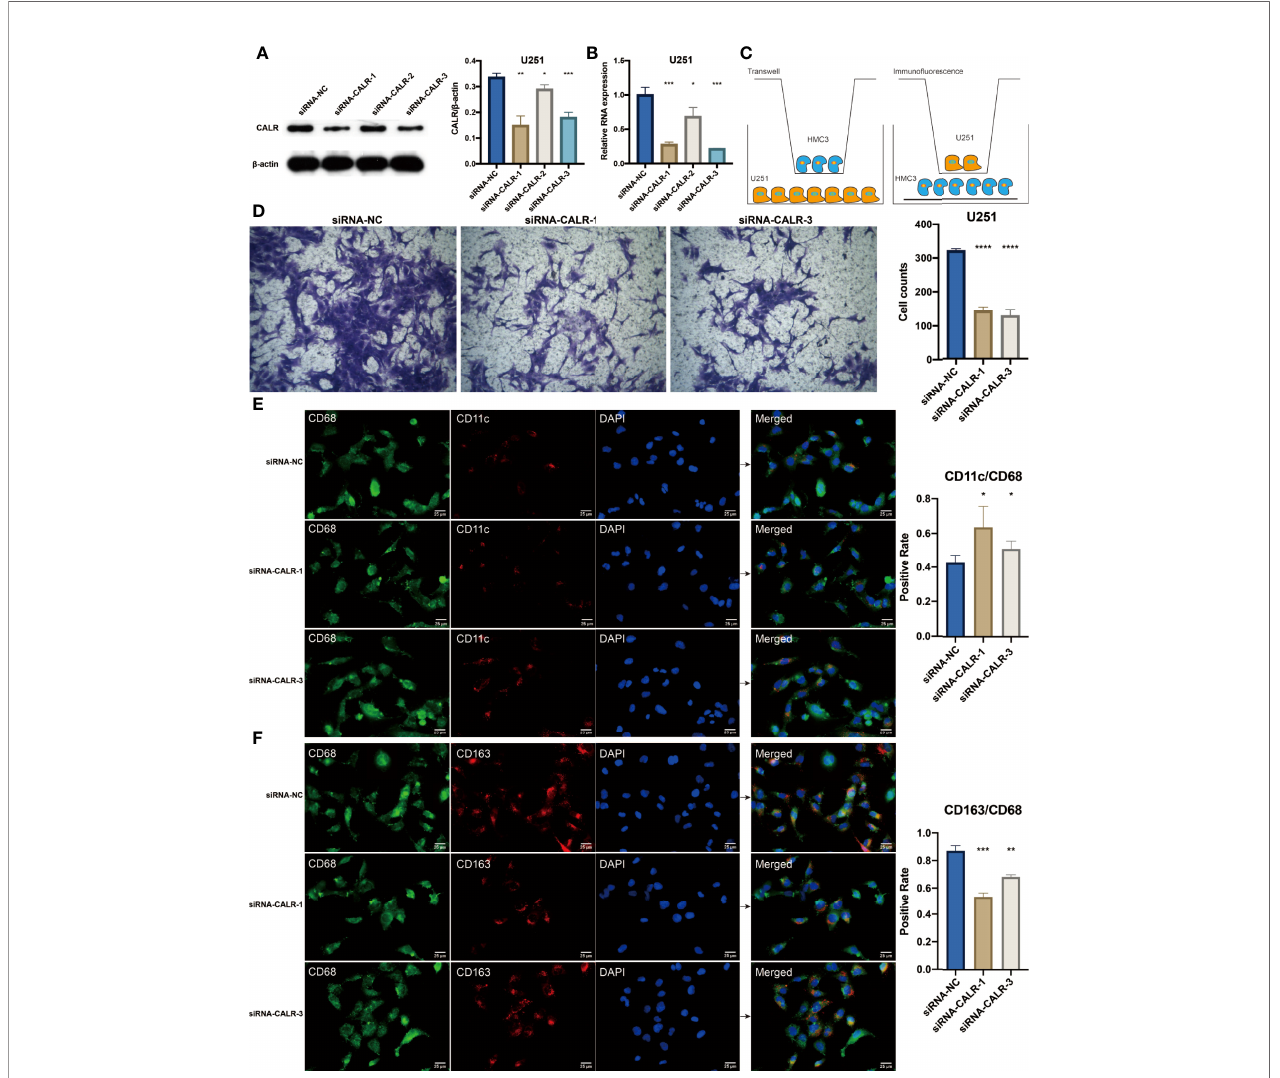
FIGURE 9 | (A) Western blotting results for U251 cells treated with siRNAs. Statistical analysis of the western blotting results in different siRNA groups. (B) Statistical analysis of the qPCR results in different siRNA groups. (C) Diagram for the coculture between HMC3 and U251 cells. (D) Transwell assay for the cocultured HMC3 cells. Statistical analysis of the migrated HMC3 cells in different siRNA groups. (E) Immuno fl uorescence staining of CD68 and CD11c in HMC3 cells. (F) Immuno fl uorescence staining of CD68 and CD163 in HMC3 cells. *P < 0.05; **P < 0.01; ***P < 0.001; ****P <